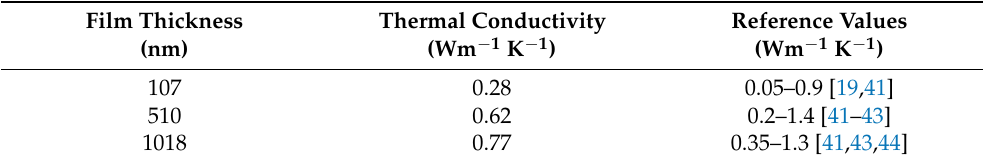
Table 5. Final measurement results for different SiO 2 thin films.